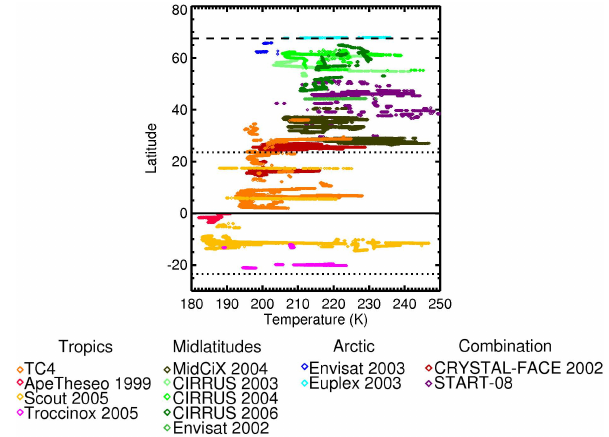
Fig. 3. The latitudinal coverage achieved by the combined dataset. The color scheme in the legend is used consistently throughout the rest of the analysis.